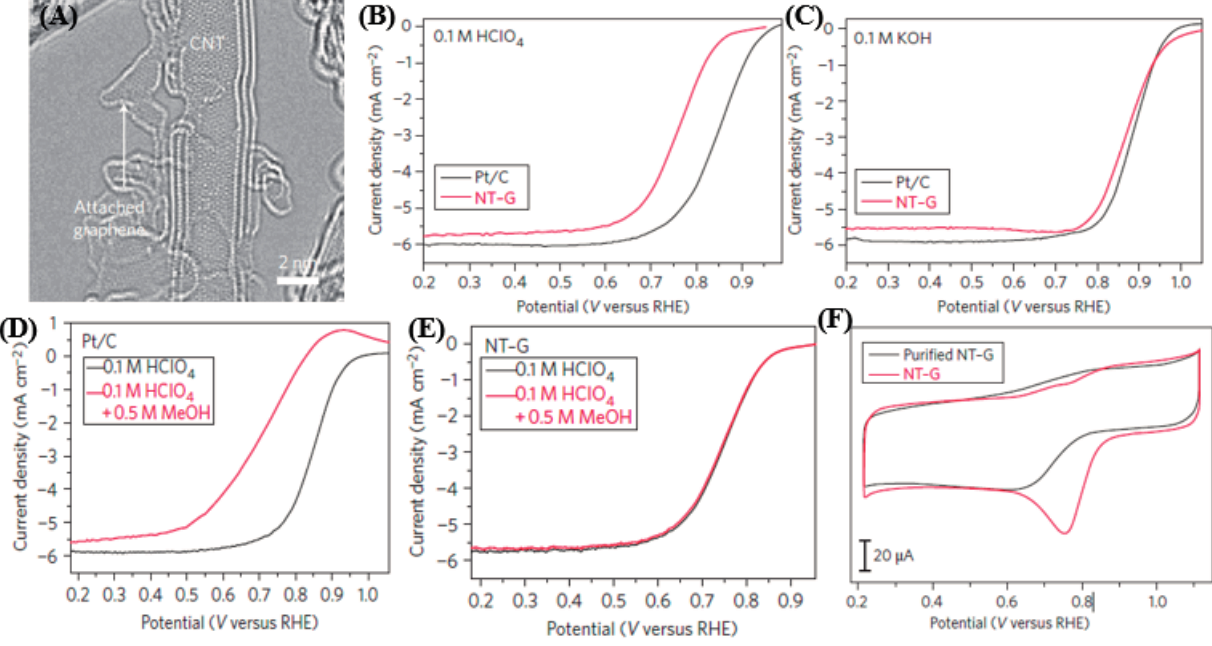
Figure 10. ( A ) Aberration-corrected TEM images of the NT-G (carbon nanotube–graphene complex) material, showing damaged outer walls and exfoliated graphene pieces attached to double- or triple-walled carbon nanotubes (CNTs). RRDE polarization curves of 20% Pt/C (black) and NT-G (red) in ( B ) O 2 -saturated 0.1 M HClO 4 and ( C ) O 2 -saturated 0.1 M KOH, respectively. ( D , E ) RRDE polarization curves of the NT-G catalyst before and after 8000 potential cycles in argon- or O 2 -saturated 0.1 M HClO 4 , respectively. Potential cycling was carried out between 0.6 and 1.0 V versus RHE at 50 mV/s. ( F ) Comparison of the RRDE polarization curves of NT-G with/without intentional iron impurity